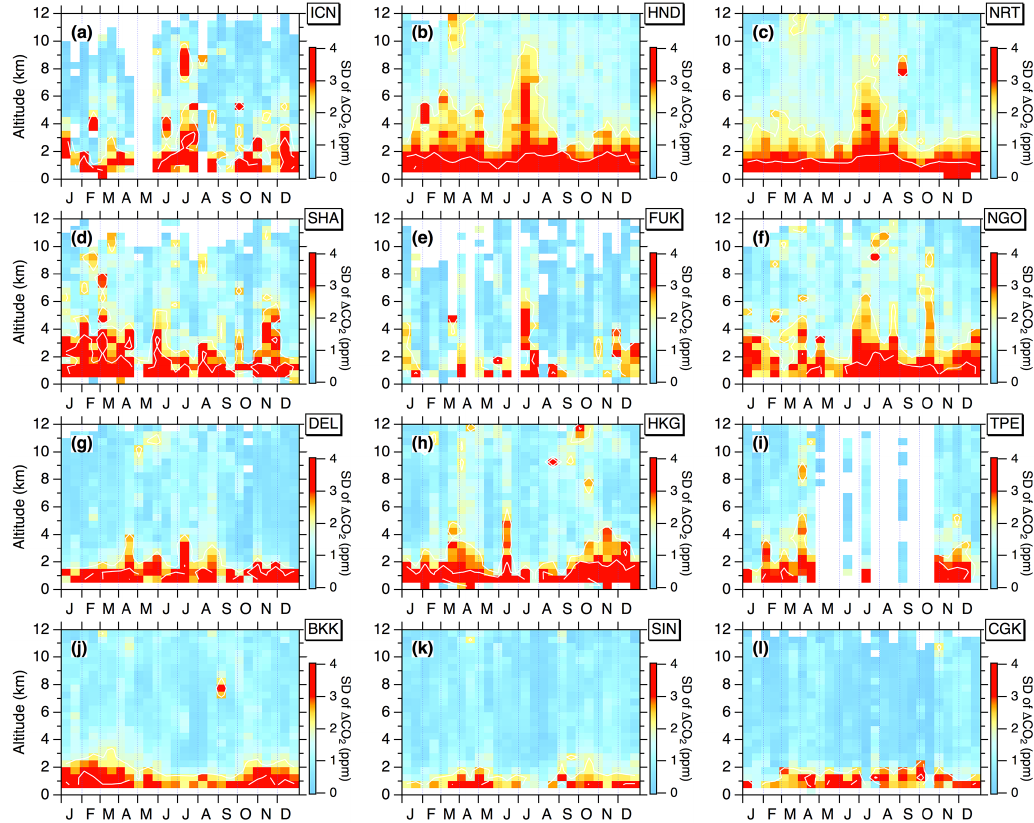
Figure 5. Same as in Fig. 4 but for standard deviations of (cid:49) CO 2 in each bin. The standard deviation is calculated only when the bin has > 5 data